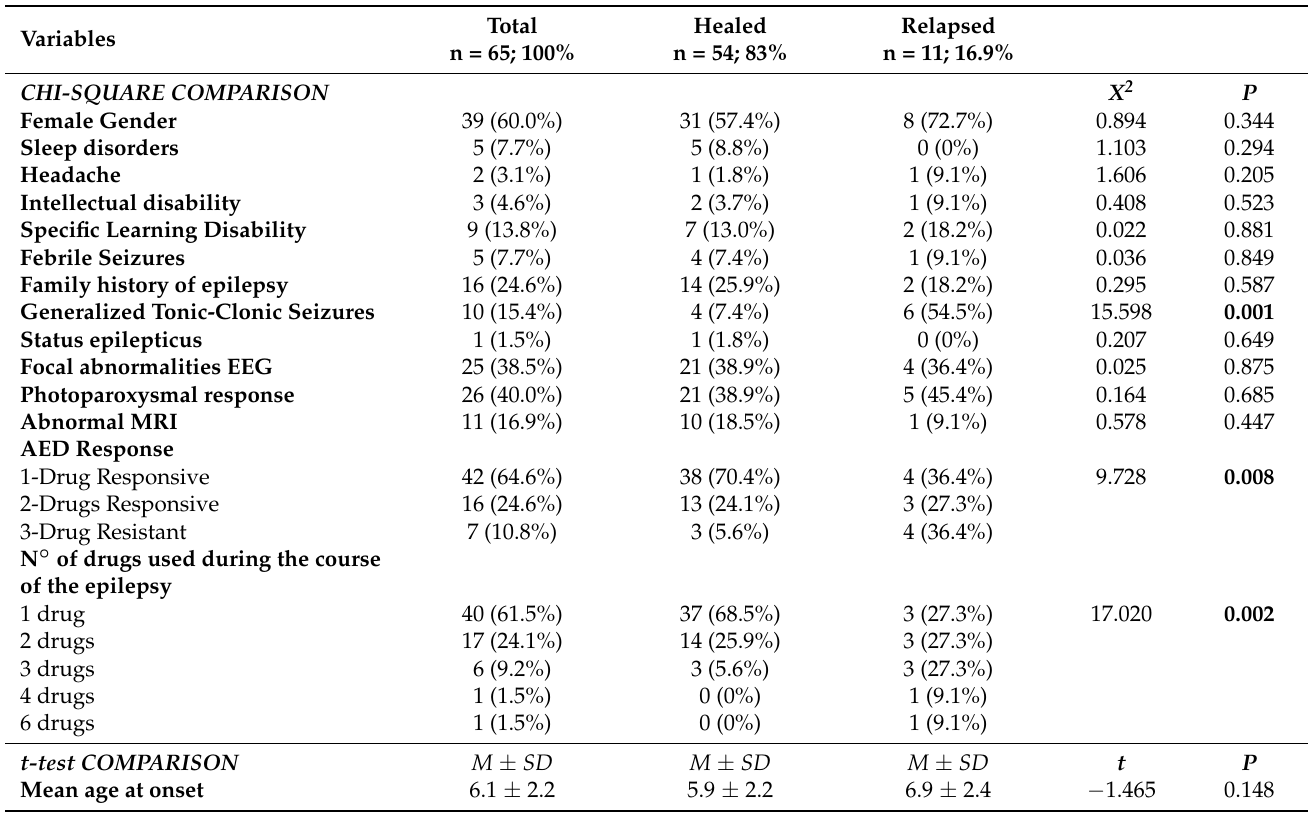
Table 2. Clinical and EEG characteristics based on the occurrence of relapses in CAE